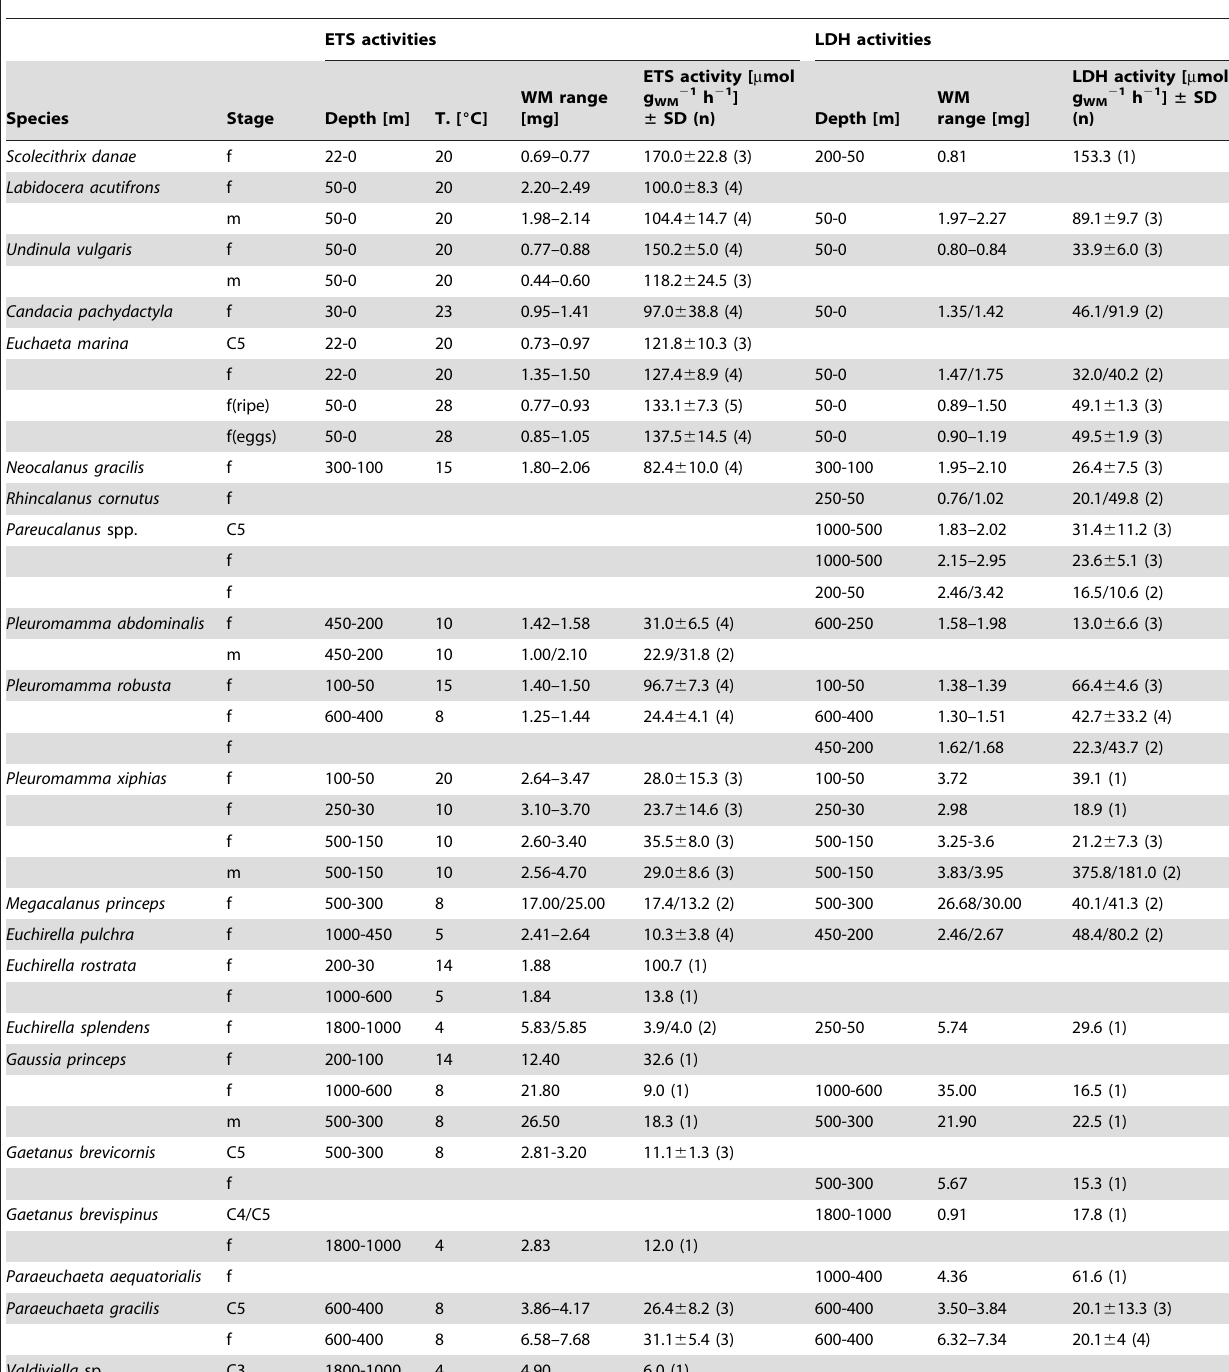
Table 3. Enzyme activities of the electron transport system (ETS) and lactate dehydrogenase (LDH) of calanoid copepods from the tropical